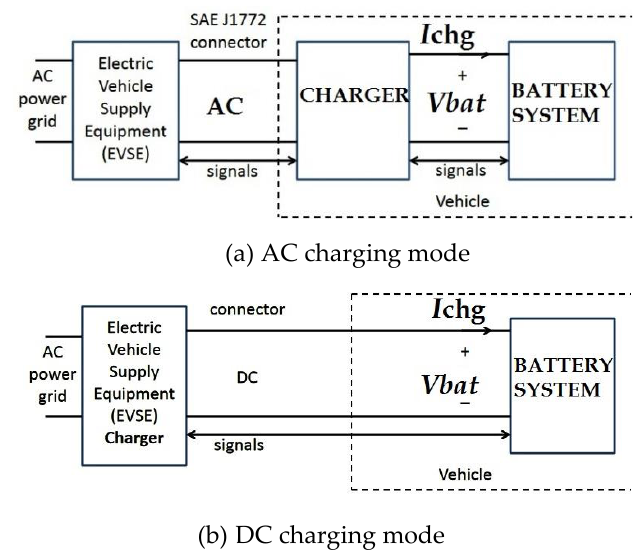
Figure 7. Diagram of electric vehicle battery charger.